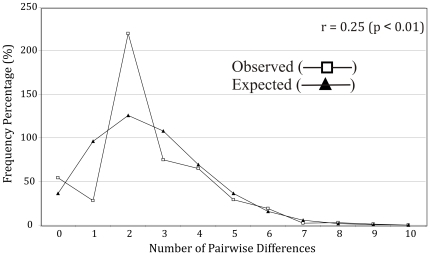
Mismatch distribution and ‘raggedness’ index (r) for the cyt b data of H. vittatus.Observed and expected pairwise differences based on 1000 replicates.